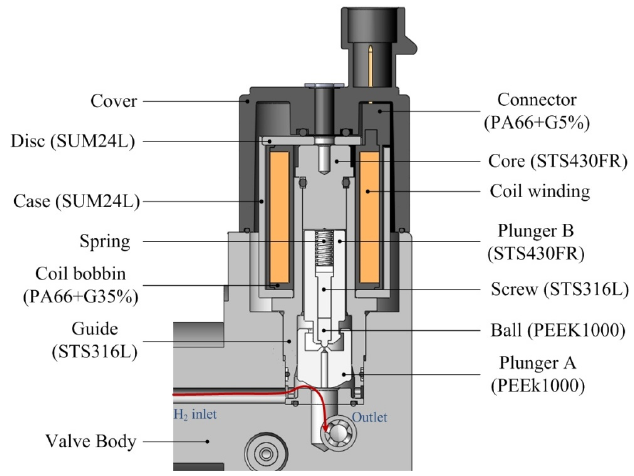
Figure 1. Construction of solenoid actuator.